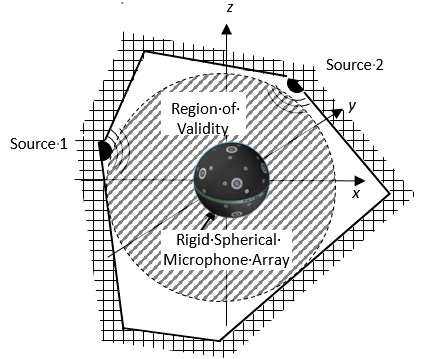
Figure 1. Validity region of spherical acoustic holography.